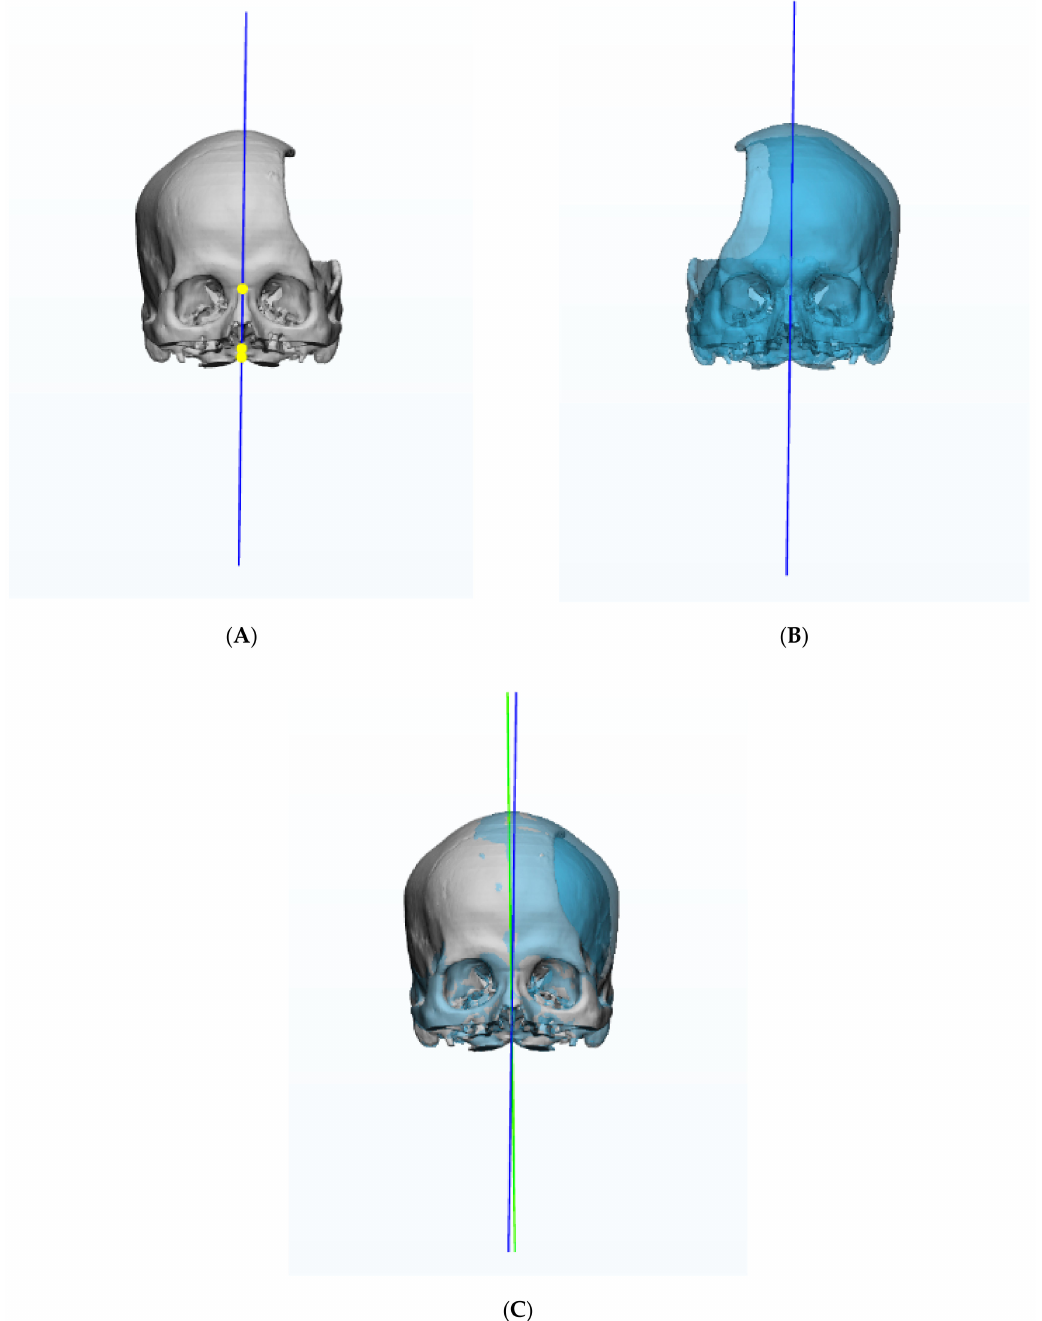
Figure 2. ( A ). initial mirror plane (in blue) created from the three reference points. ( B ). Mirror image of the original defect model ( C ). Surface based registration was performed and moved mirror plane was obtained (in